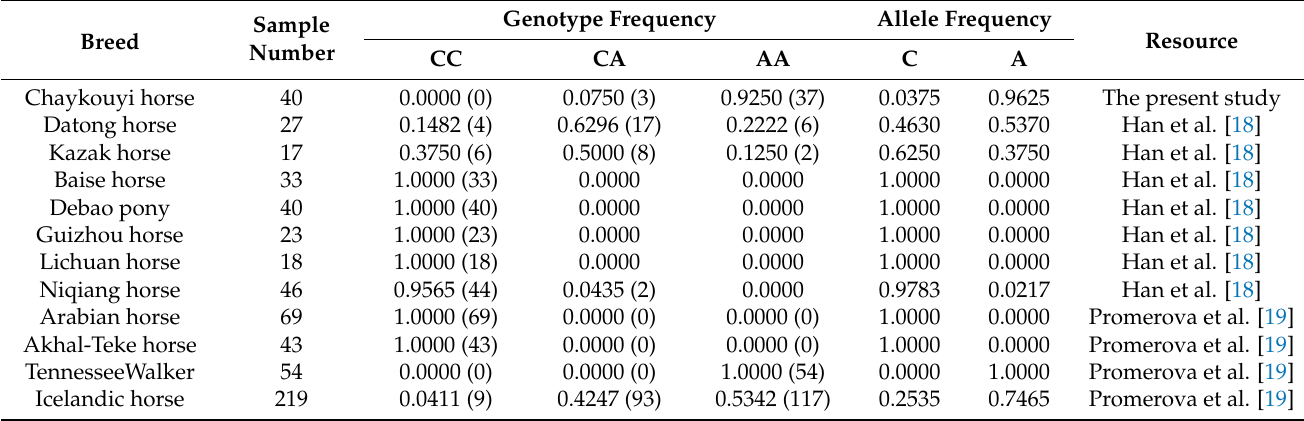
Table 2. Genotype and allele frequencies of the DMRT3 gene mutation in Chinese indigenous horses and foreign horses.